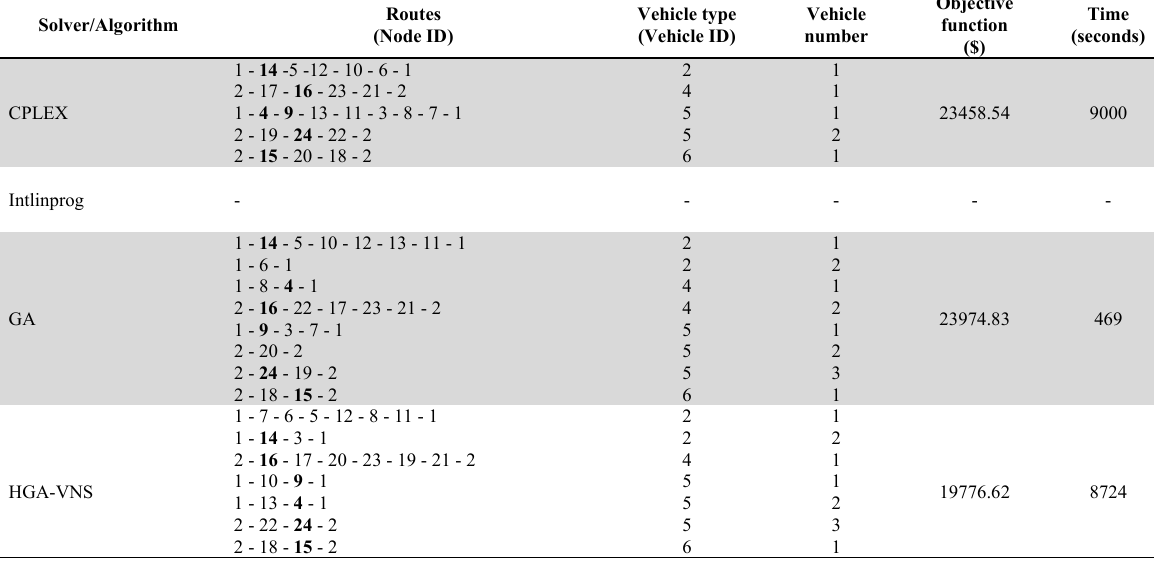
Objective Vehicle type Vehicle function (Vehicle ID) number